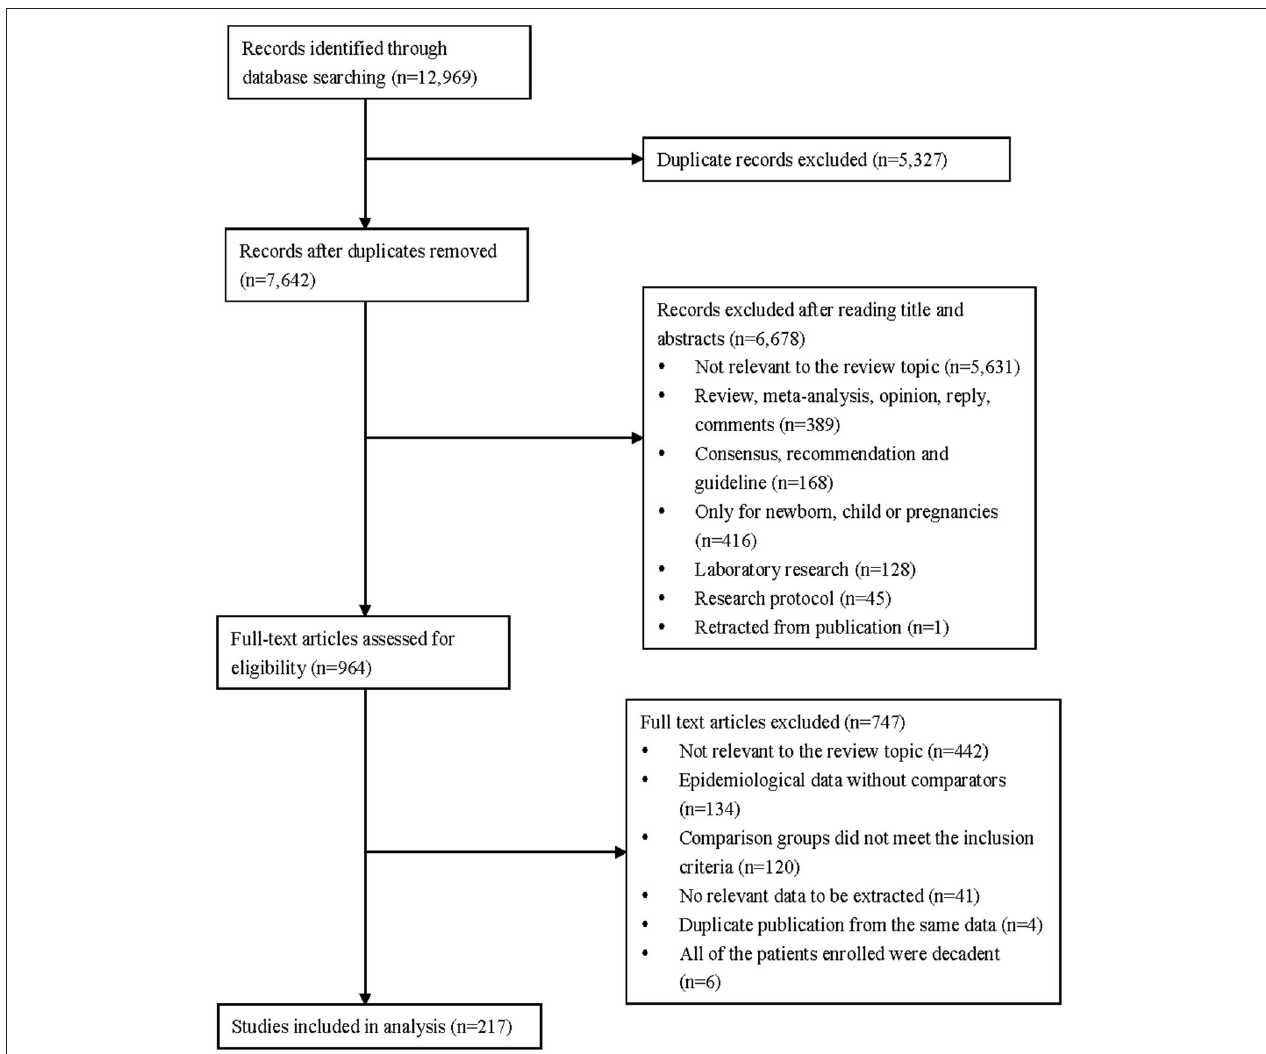
FIGURE 1 | Flow diagram of the study selection for inclusion in the systematic